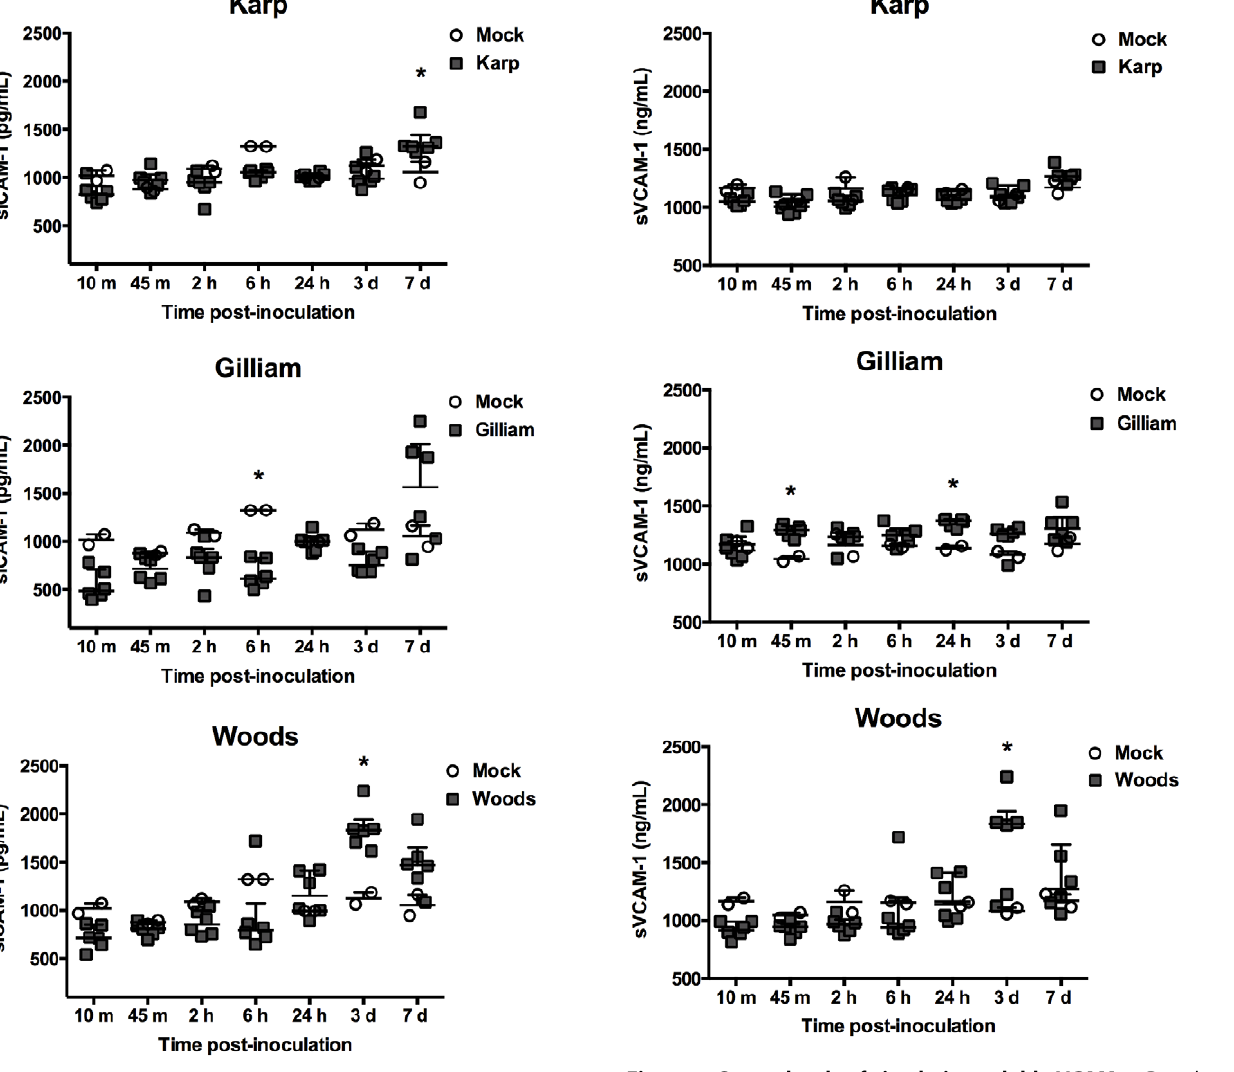
Figure 4. Serum levels of circulating soluble ICAM-1. Dot plots demonstrates ICAM-1 levels in inoculated mouse sera. (Mock in- oculation; n=2 per time point, O. tsutsugamushi inoculation; n=6 per time point). Bars indicate median and error bars represent interquartile range. The asterisks indicate significant differences ( P , 0.05).